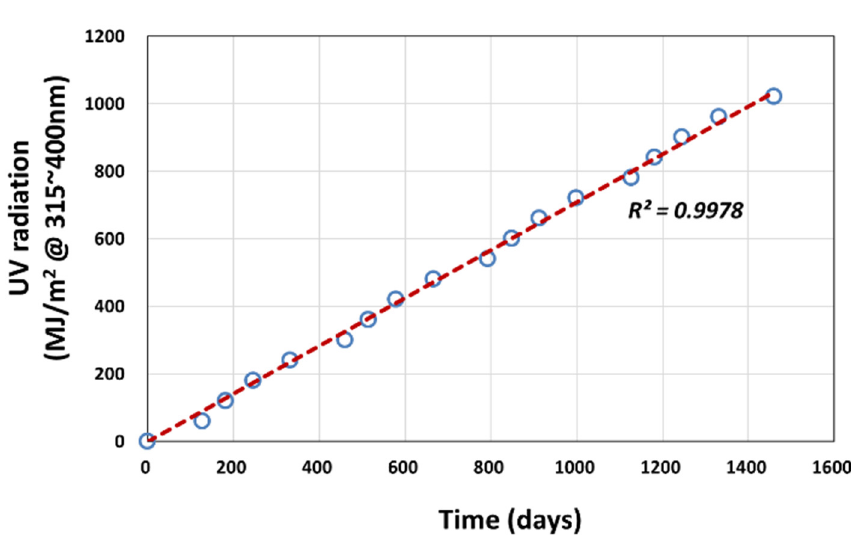
Figure 12. Cumulative UV radiation at 315–400 nm received ( D ) versus outdoor exposure time ( t ) in Seosan.